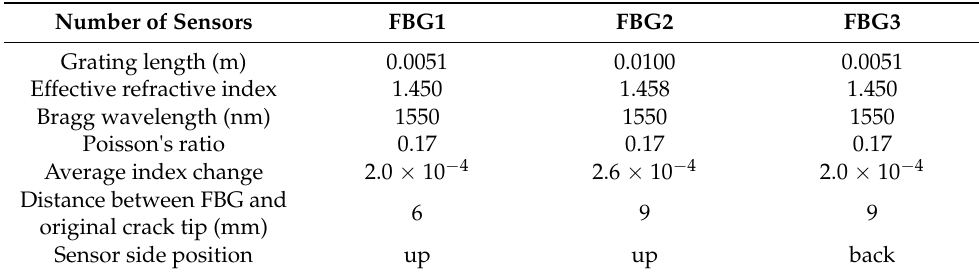
Figure 4. Non ‐ uniform strain distribution at sensor positions of FBG1 obtained by the DIC method.